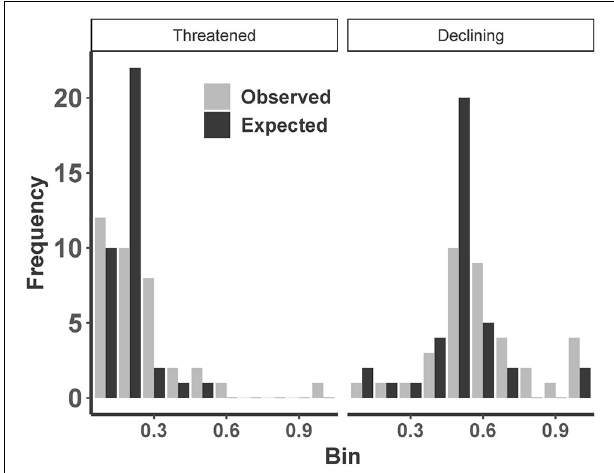
FIGURE 1 | Frequency histogram across bird orders of proportion of species that are threatened or declining. The expected distributions are based on simulations.